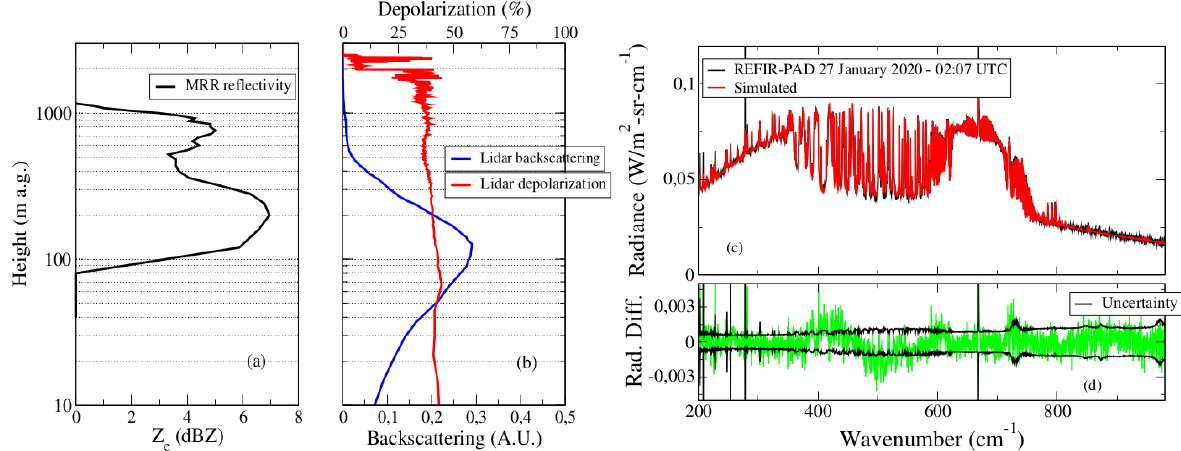
Figure 10. (a) Reflectivity profiles provided by the MRR on the day 27 January 2020 at 02:07UTC. (b) Backscattering (blue curve) and depolarization (red curve) lidar profiles. (c) Comparison of a REFIR-PAD measurement (black curve) at 08:24UTC on 10 December 2020 with the simulated spectra at the last iteration (red curve). (d) Comparison of the differences between the measured and the simulated spectrum (green curve) with the instrumental noise (black curve).